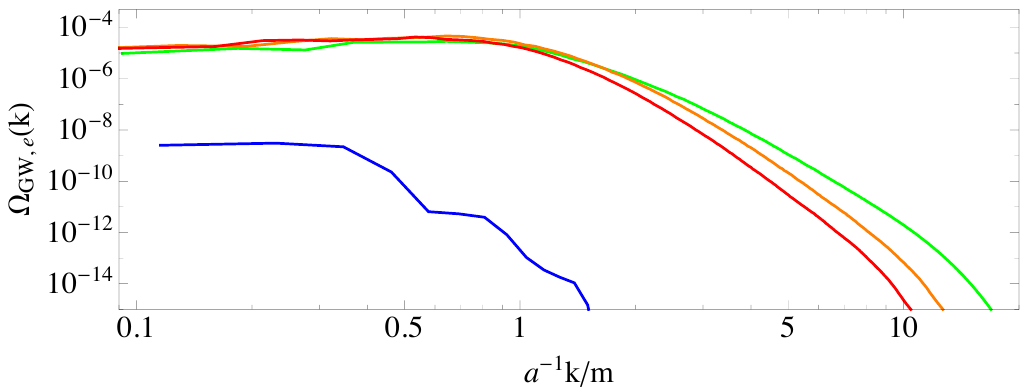
Figure 15 . Spectrum of Gravitational waves (cid:10) physical momentum GW ; e ( k ) as a function of the a (cid:0) 1 k . The spectrum is shown at di(cid:11)erent moments in time which correspond to: the end of linear preheating at a ’ 1 : 16 (blue), shortly after the beginning of the non-linear regime at a ’ 1 : 45 (green), at a ’ 2 : 1 (orange), and at the end of the simulation a ’ 2 : 5 (red).